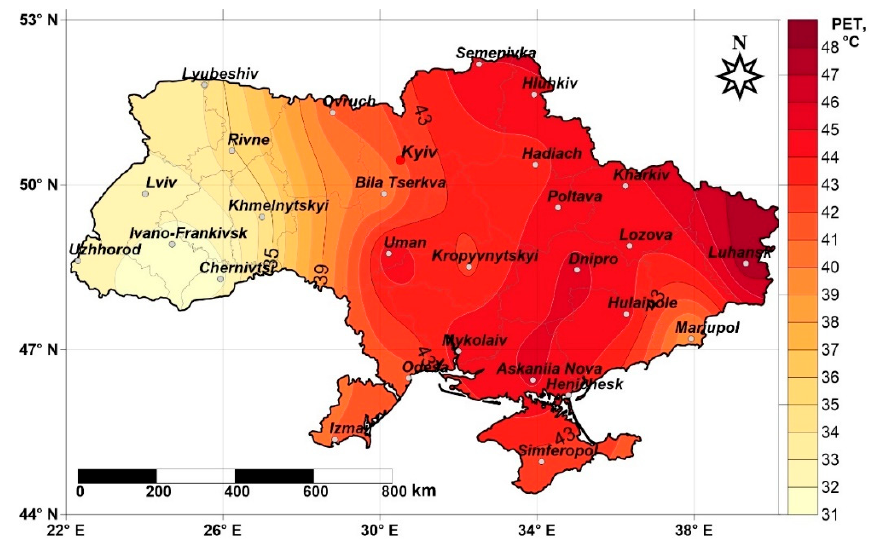
Figure 4. Mean PET value (°C) at 12 UTC in the period from 31 July to 12 August 2010. Strong and extreme heat stress prevailed at 12 UTC during the period from 31 July to 12 August at the stations where the heat wave was observed (Table 4). Exceptions oc ‐ curred at Ovruch and Izmail where slight and moderate heat stress prevailed. Ovruch is situated close to the Western region where the 2010 HW event was not observed, as well as Izmail lies to the southwest. Extreme heat stress was observed every day at 12 UTC during 31 July–12 August at Poltava, Lozova, Luhansk, Kharkiv, Hulaipole and Mykolaiv. One day with strong heat stress and others with extreme were found in Kropyvnytskyi, Hlukhiv and Dnipro. Table 4. Frequency (%) of days with different grades of physiological stress on human beings at 12 UTC during the period from 31 July to 12 August 2010.